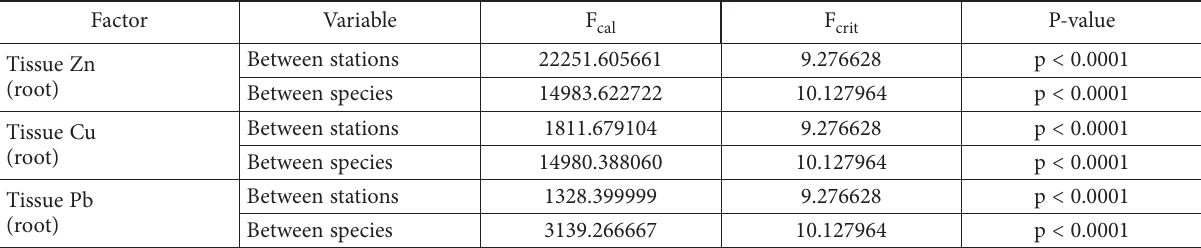
Table 4. ANOVA of heavy metal concentrations in the root samples between stations and between species Factor Variable F cal F crit P-value Tissue Zn